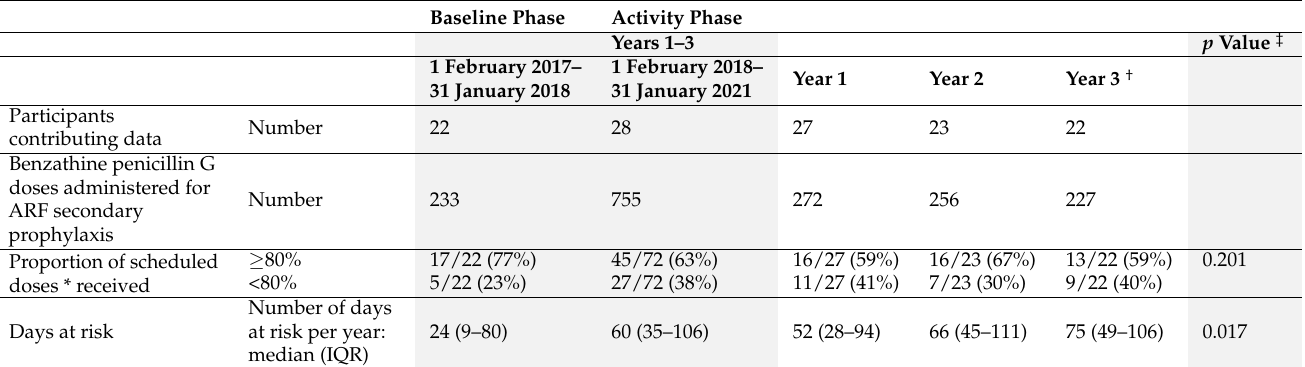
Table 4. Adherence to secondary prophylaxis with intramuscular benzathine penicillin G